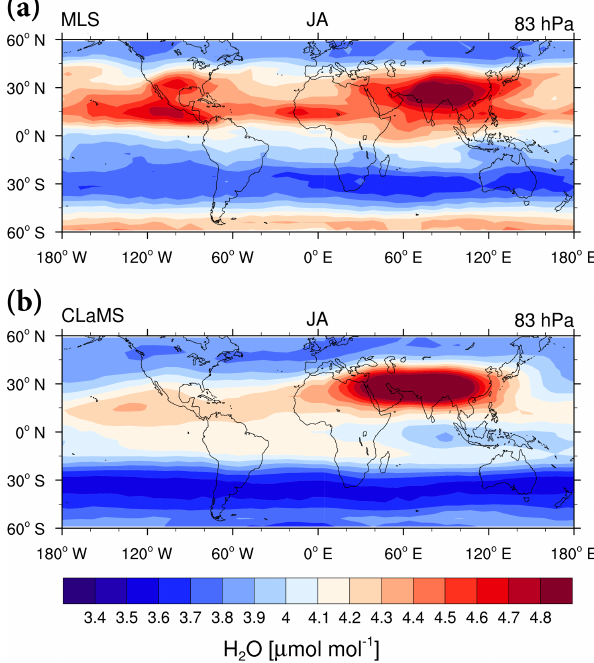
Figure 2. Maps of H 2 O (µmolmol − 1 ) during JA 2010–2014 at 83hPa from (a) MLS and (b) CLaMS data, which were processed to enable the comparison with MLS data (see text and Sect. 2.3). H 2 O values above (below) 4.8 (3.4) µmolmol − 1 are shaded in dark red